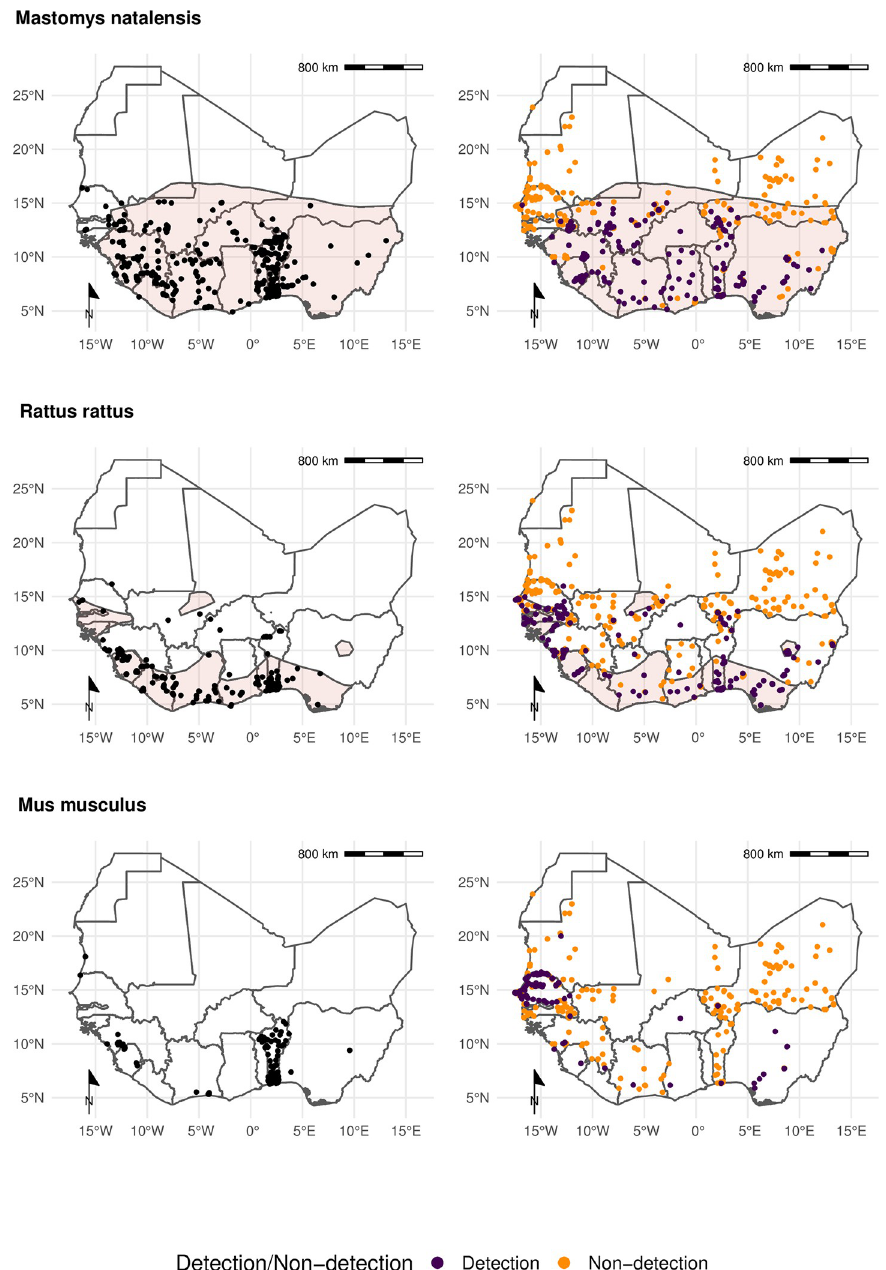
Fig 3. Locations of detection and non-detection sites for rodent species in West Africa Each row corresponds to a single rodent species. L) Presence recorded in GBIF (black points) overlaid on IUCN species range (red-shaded area). R) Detection (purple) and non-detection (orange) from rodent trapping studies overlaid on IUCN species ranges. M. musculus has no IUCN West African range. Basemap shapefile obtained from GADM 4.0.4 [38]. Rodent trapping studies identified additional rodent host species for six pathogens; Lassa mammarenavirus (5), Toxoplasma gondii (4), Usutu virus (2), Coxiella burnetii (2), Escherichia coli and Klebsiella pneumoniae (both 1), that were not present in this consolidated host-patho- gen association dataset.